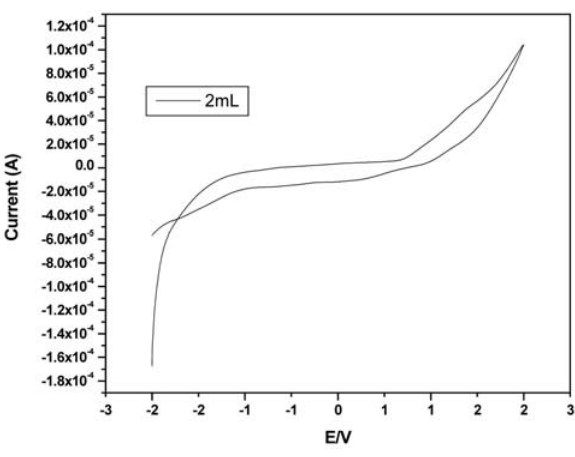
Figure 2b. Cyclic voltammograms interpretation of 5b in acetoni- trile